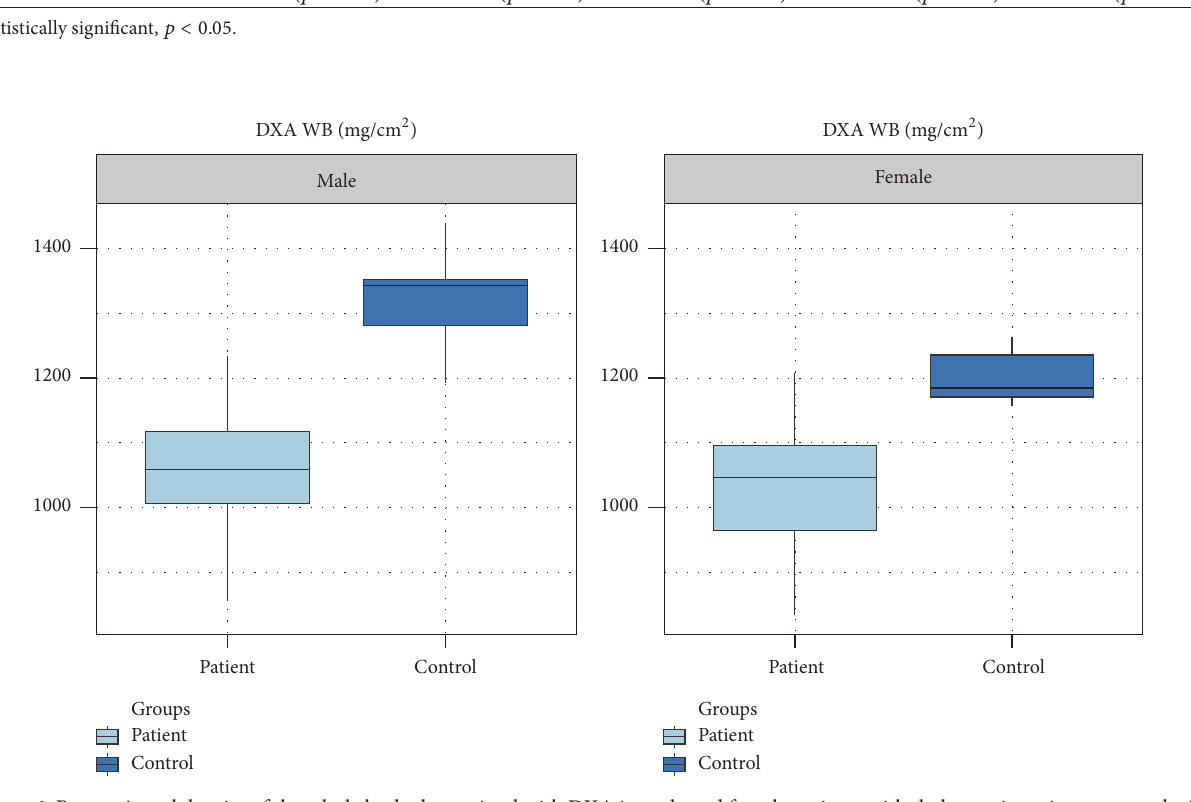
Figure 1: Bone mineral density of the whole body determined with DXA in male and female patients with thalassemia major compared with controls. There is established osteoporosis in both male and female patient groups, compared to controls ( 𝑝 = 0.001 in males, 𝑝 < 0.0001 in females,